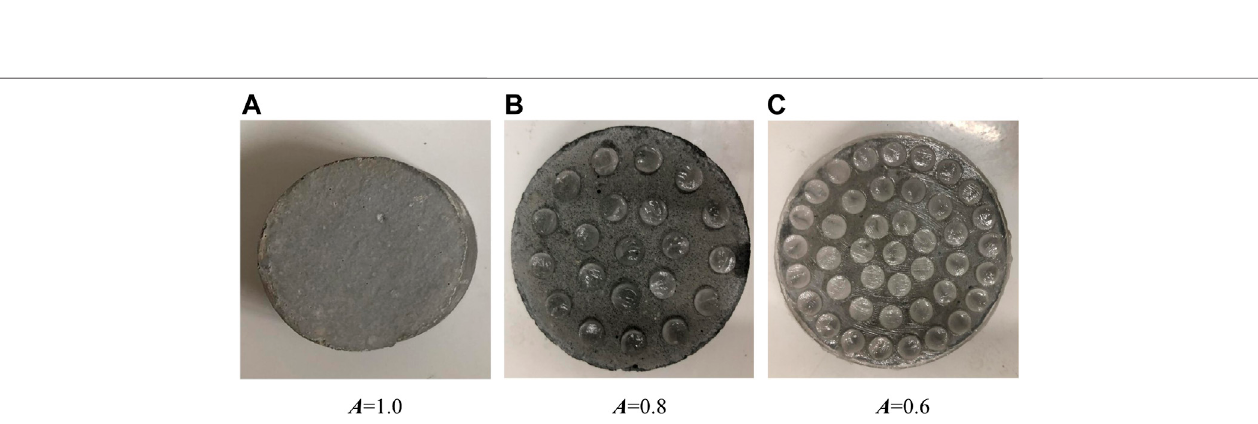
FIGURE 5 | Examples of the specimen with different contact area ratios: (A) A = 1.0; (B) A = 0.8; (C) A = 0.6.